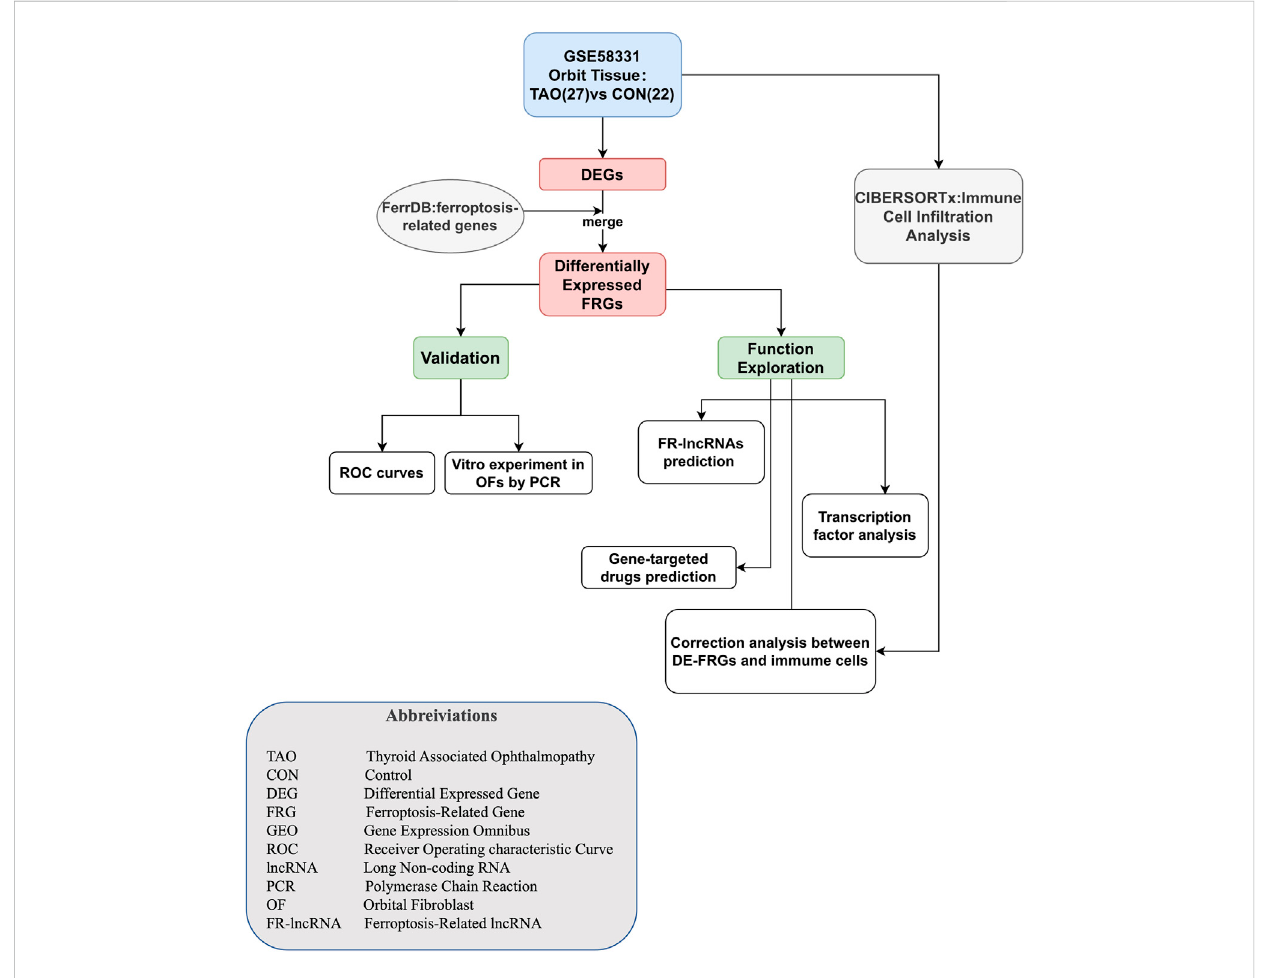
FIGURE 1 The fl ow diagram of our